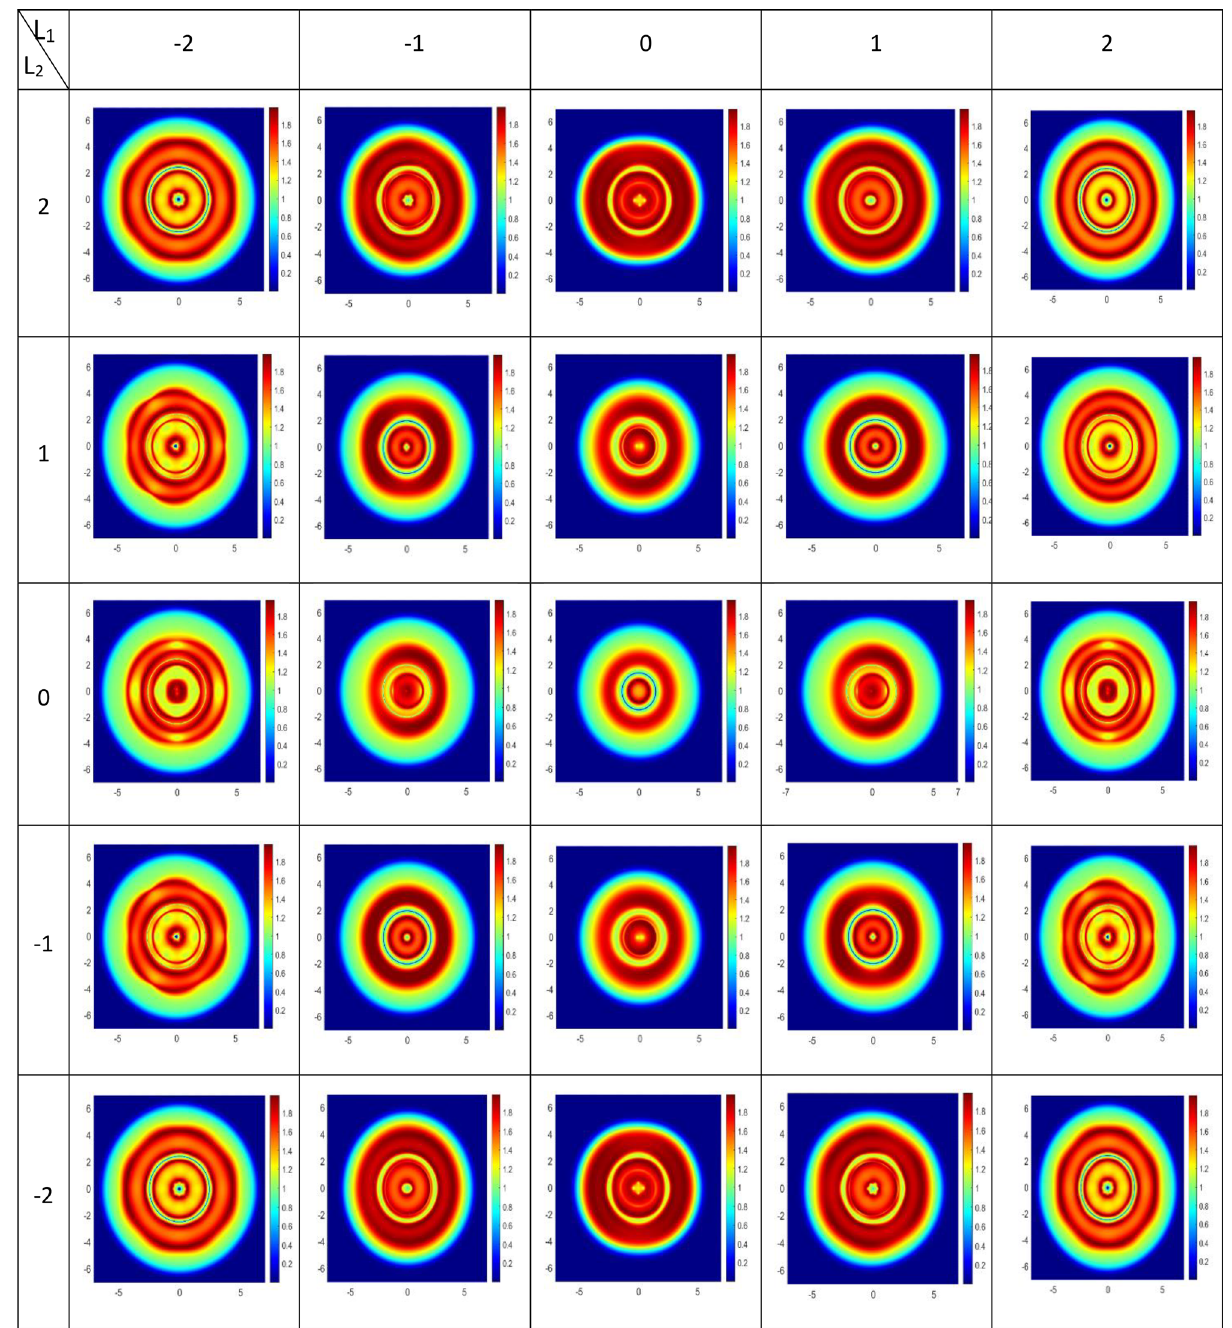
2, . . . 2 ( i 1, 2 ) . = − + = 0, � 1 � 2 = = =